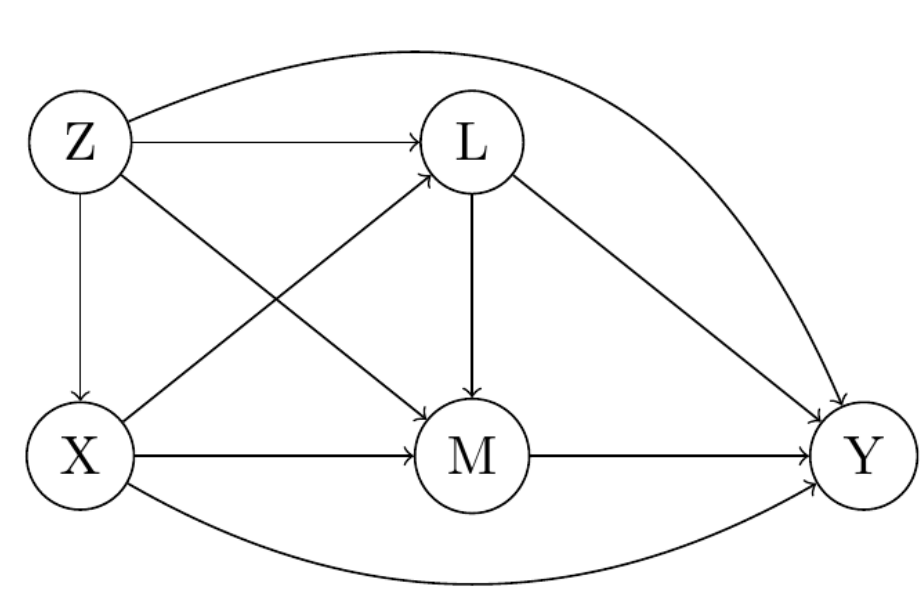
Figure 2: Causal relations between grandparent education (X), parental characteristics (M), and child cognitive ability (Y) in the presence of treatment-induced mediator– outcome confounders